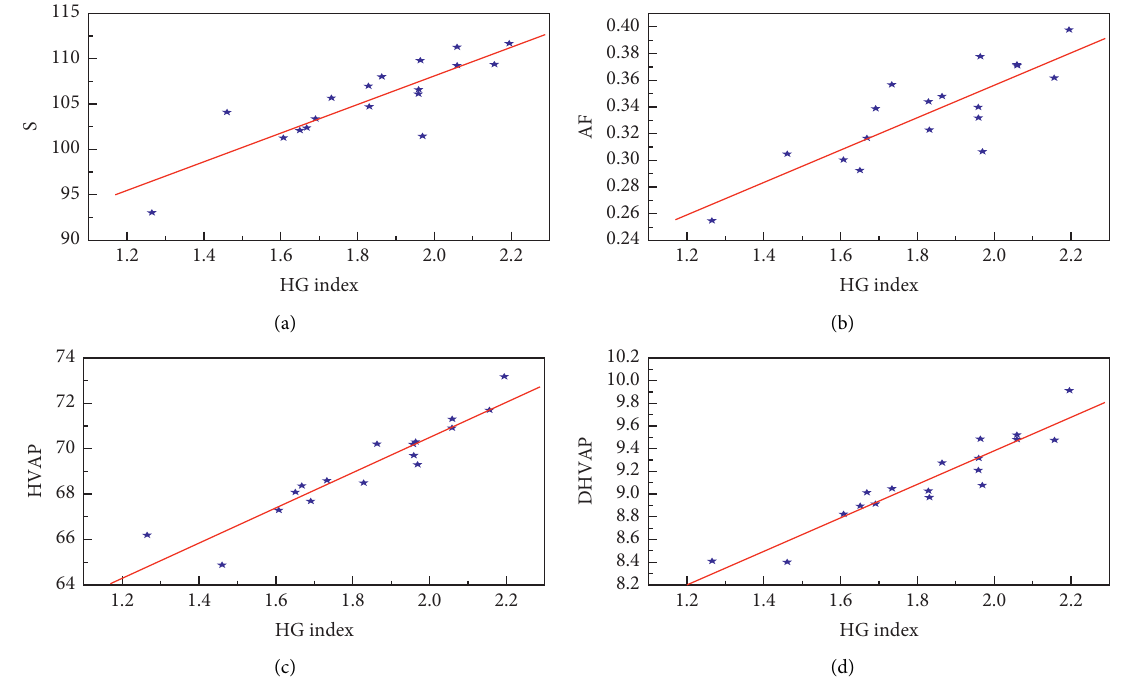
Figure 3: Scatter diagram of physical properties S , AF, HVAP, and DHVAP with the HG index.